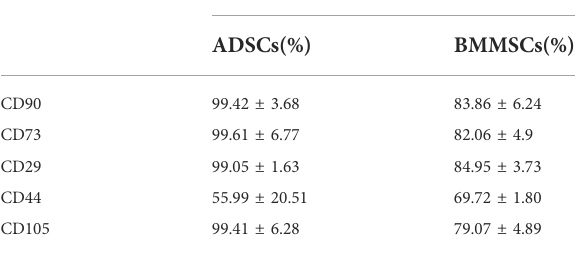
TABLE 2 Flow cytometry analysis of ADSCs and BMMSCs lines con fi rmed the presence of MSC markers CD90, CD73, CD29, CD44, and CD105. Percentage of cells expressing the speci fi c antigens for ADSCs and BMMSCs was analyzed using Kaluza software for 4 independent